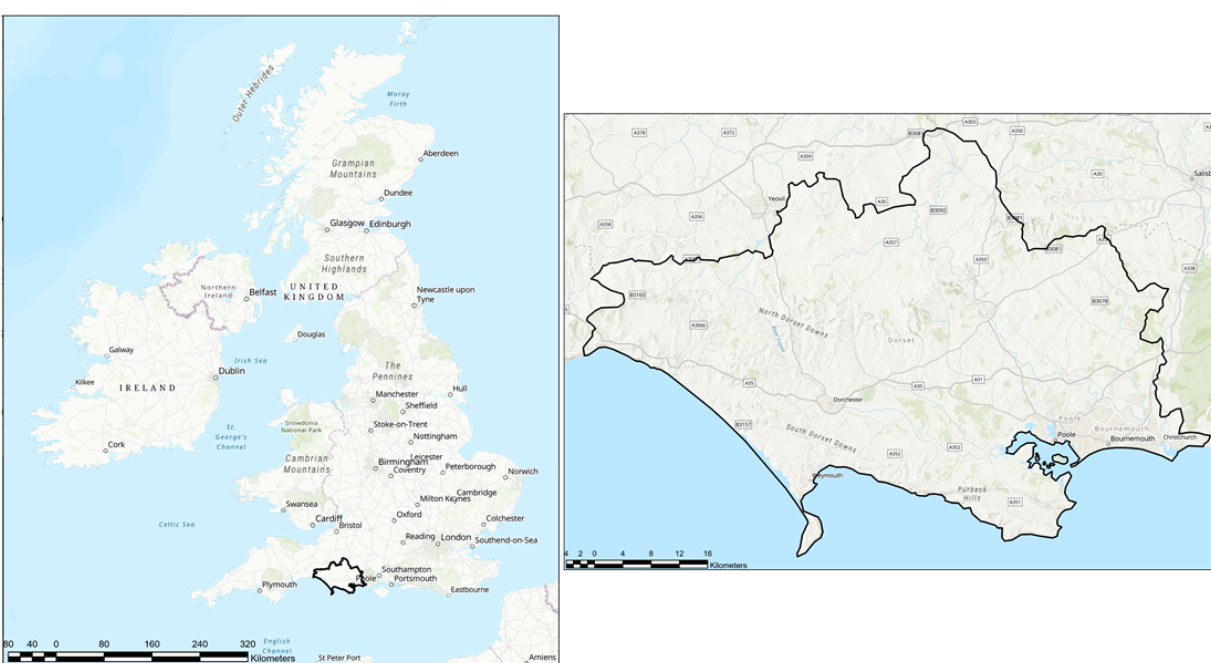
Figure 2. Location of West Dorset, United Kingdom. Source: The Danish Agency for Data Supply and Efficiency